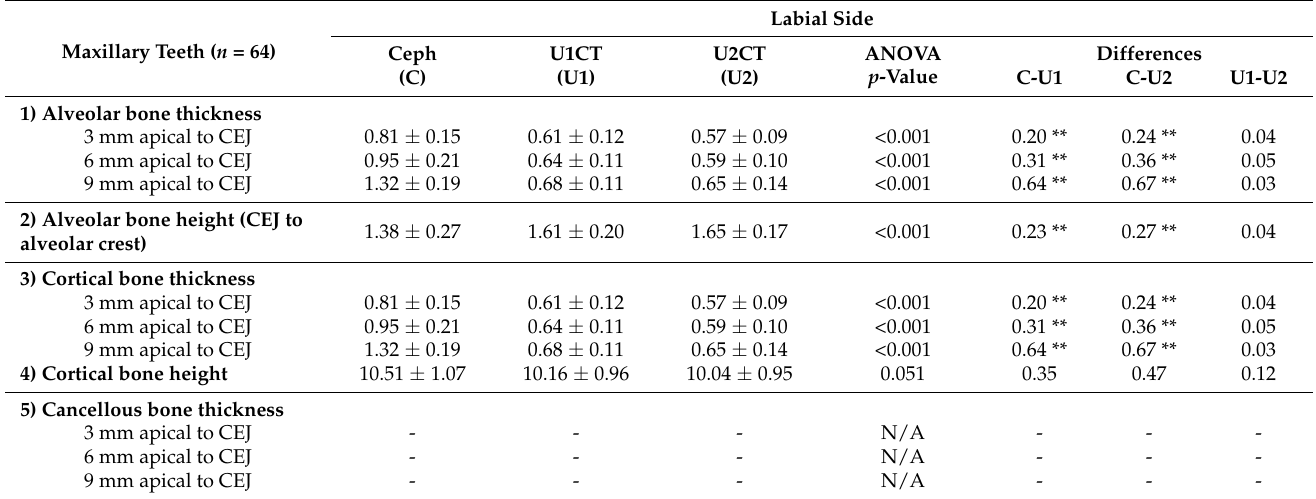
Table 1. Comparisons of labial alveolar bone between Ceph, U1CT, and U2CT.